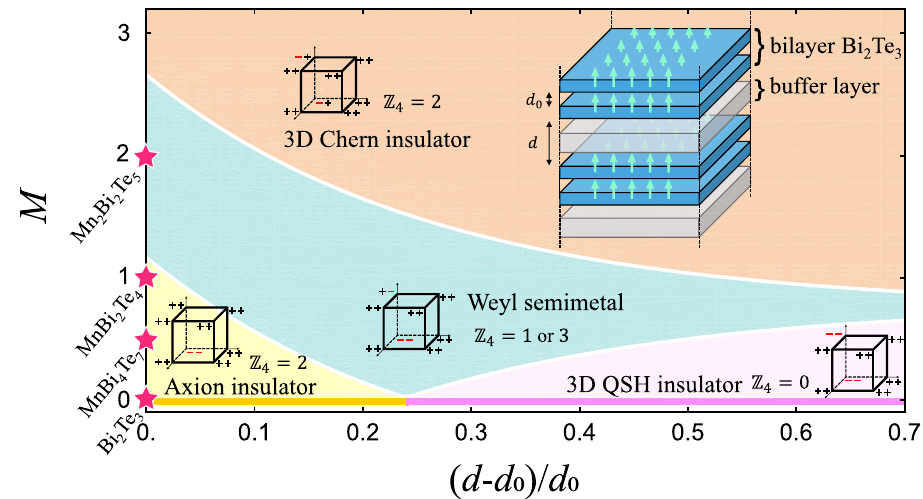
(cid:1) (cid:3) = d 0 and magnetization 4 indices with parities.